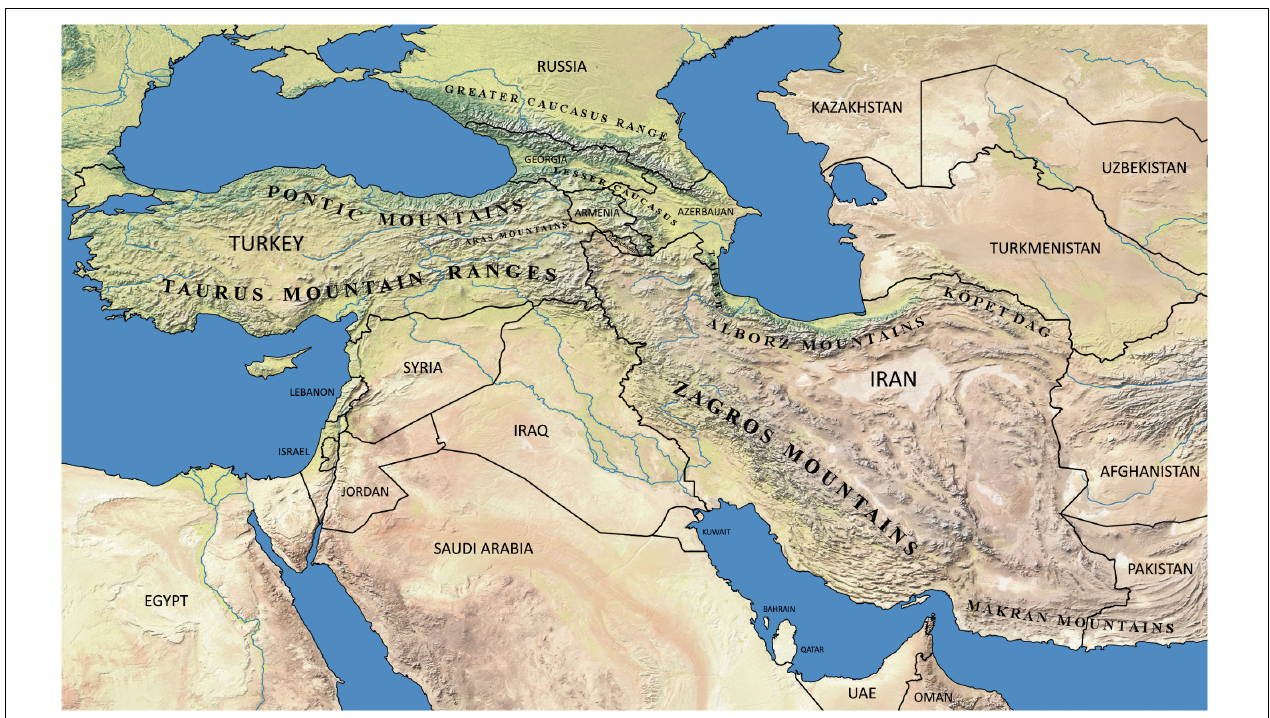
FIGURE 3 | Main mountain ranges of the Caucasus region and the Middle East (original source: Natural Earth raster + vector